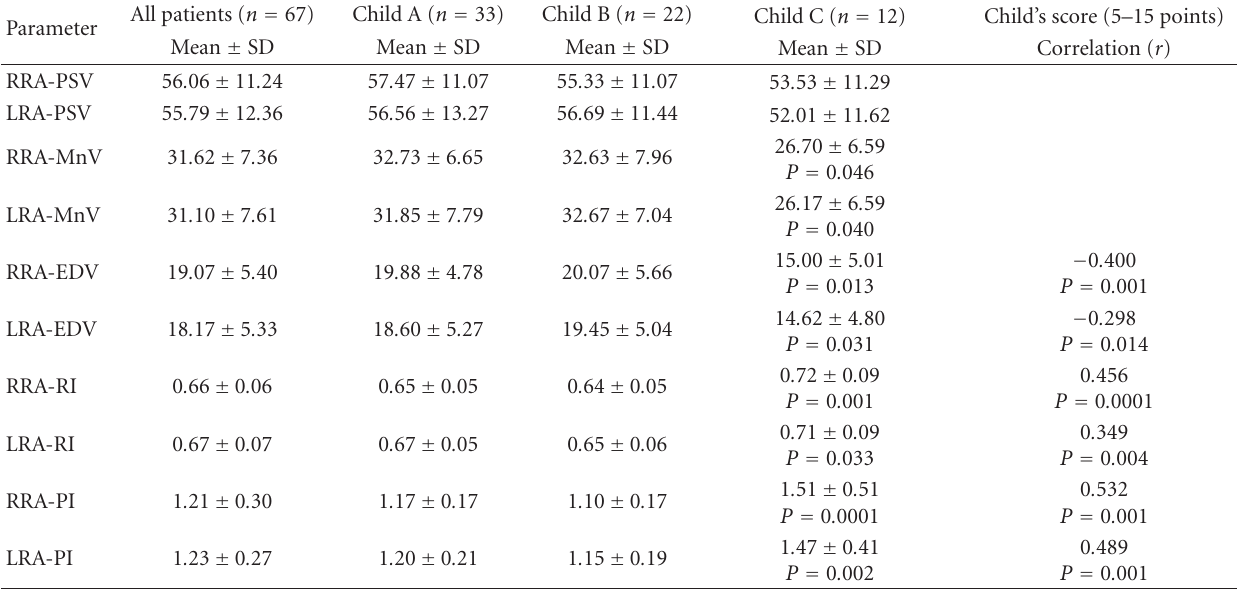
Table 4: Renal Doppler US parameters in patients with liver cirrhosis according to Child-Pugh